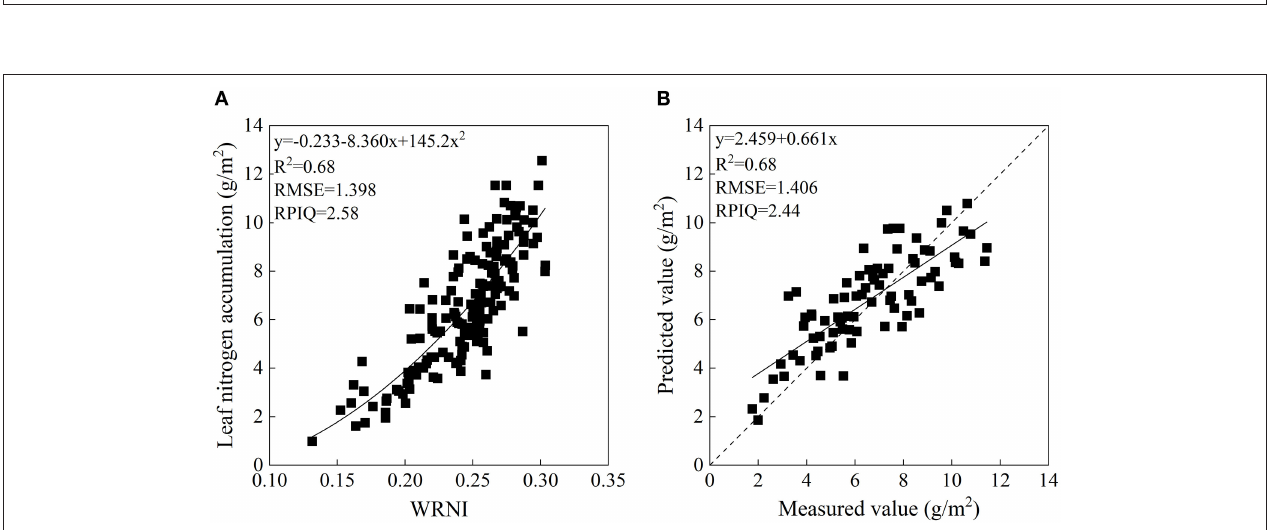
FIGURE 8 | The relationship between leaf nitrogen accumulation (LNA) and WRNI (A) . Measured and predicted LNA of the validation dataset based on WRNI (B) .